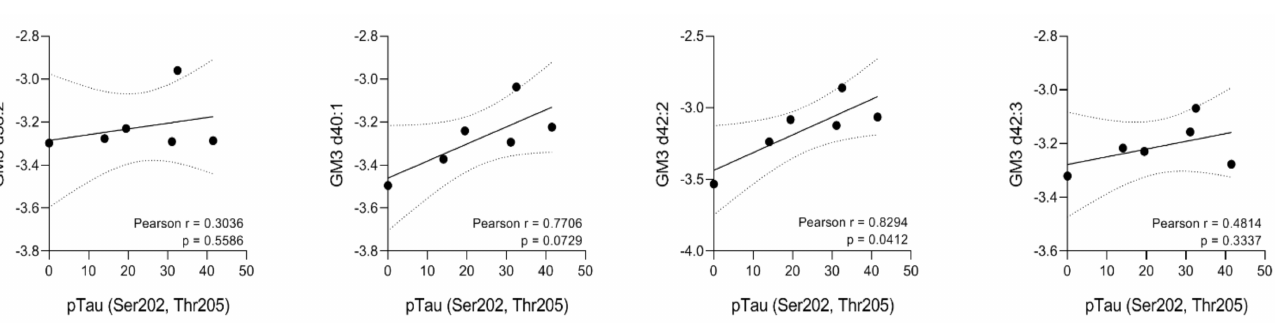
Figure 5. Increased levels of GM3 ganglioside species in the brainstem of SHR24 transgenic rats. ( A ) Heatmap showing results from significance testing as -log10( p -value) ( B ) Volcano plots show the results from the statistical analysis of the GSL profile in 12-month-old and 14-month-old TG vs. CN animals. The dashed line represents a p-value threshold of 0.05. ( C ) Confidence intervals of selected gangliosides from the GM3 class that were significantly altered in the brainstem of SHR24 rats when compared to controls. Data are shown as Mean ± SEM.